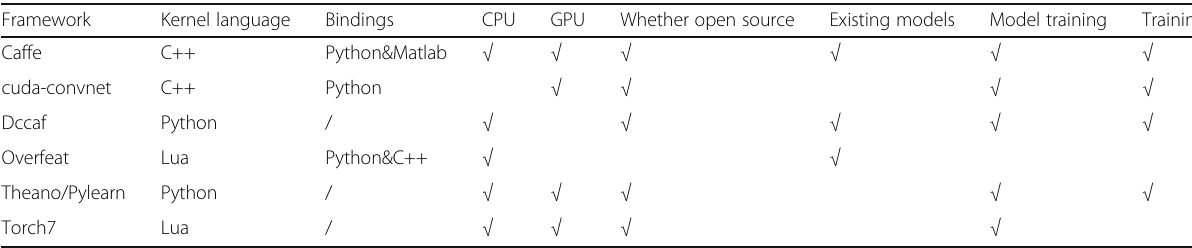
Table 1 Deep learning framework comparison